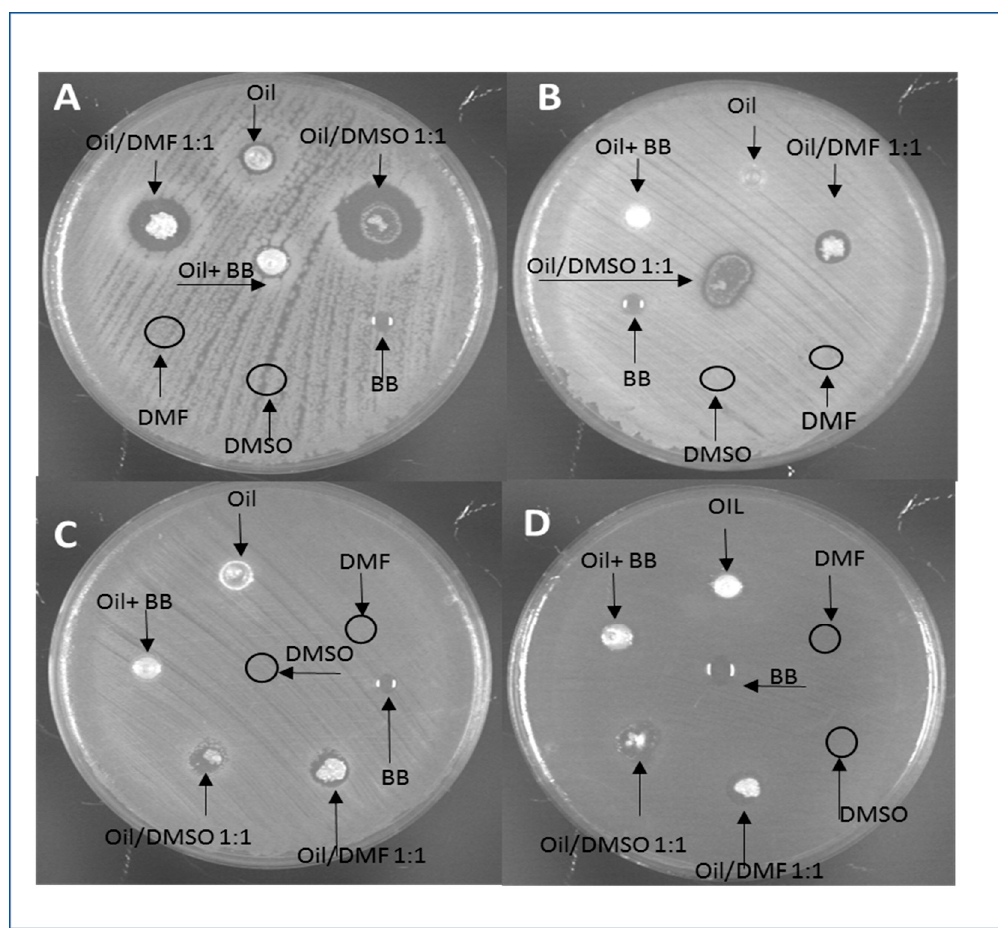
Figure 1. Representative images of Agar diffusion tests. Samples of H. illucens oil or oil mixed 1:1 with dimethylsulfoxide (DMSO), N,N Dimethylformamide (DMF) and Benzyl benzoate (BB) were loaded on LB agar plates inoculated with B. subtilis ( A ), S. aureus ( B ) E. coli ( C ), and P. aeruginosa ( D ). Upon 24-h growth, inhibition halos were observed and measured.